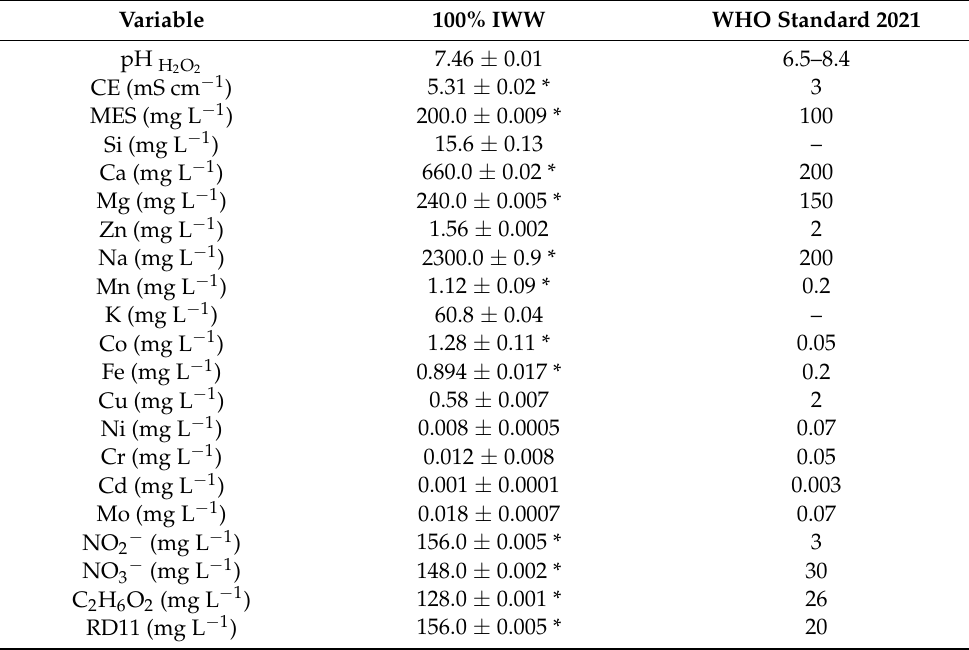
Table 1. Composition of initial industrial wastewater before dilution (100% IWW) and World Health Organization (WHO) standard. Three replications ± SD of each